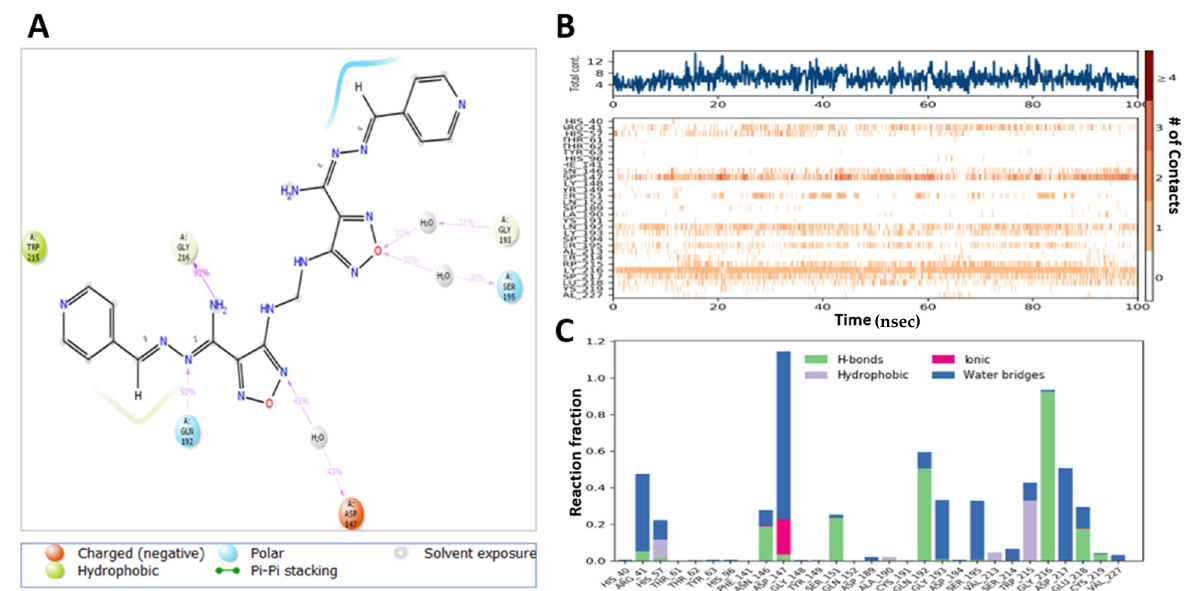
Figure 14. Interaction diagram of M3 with TMPRSS2 observed during the molecular dynamic simulation. ( A ) The protein– ligand interaction diagram. ( B ) The top panel showed the specific contact of TMPRSS2 protein with M3 in each trajectory course, the bottom panel showed the amino acid residues that interact with the ligand in the trajectory time frame. The residues making more than one contact were shown in a darker color shade. ( C ) Schematic diagram of ligand interaction with the amino acid residues of protein during MD